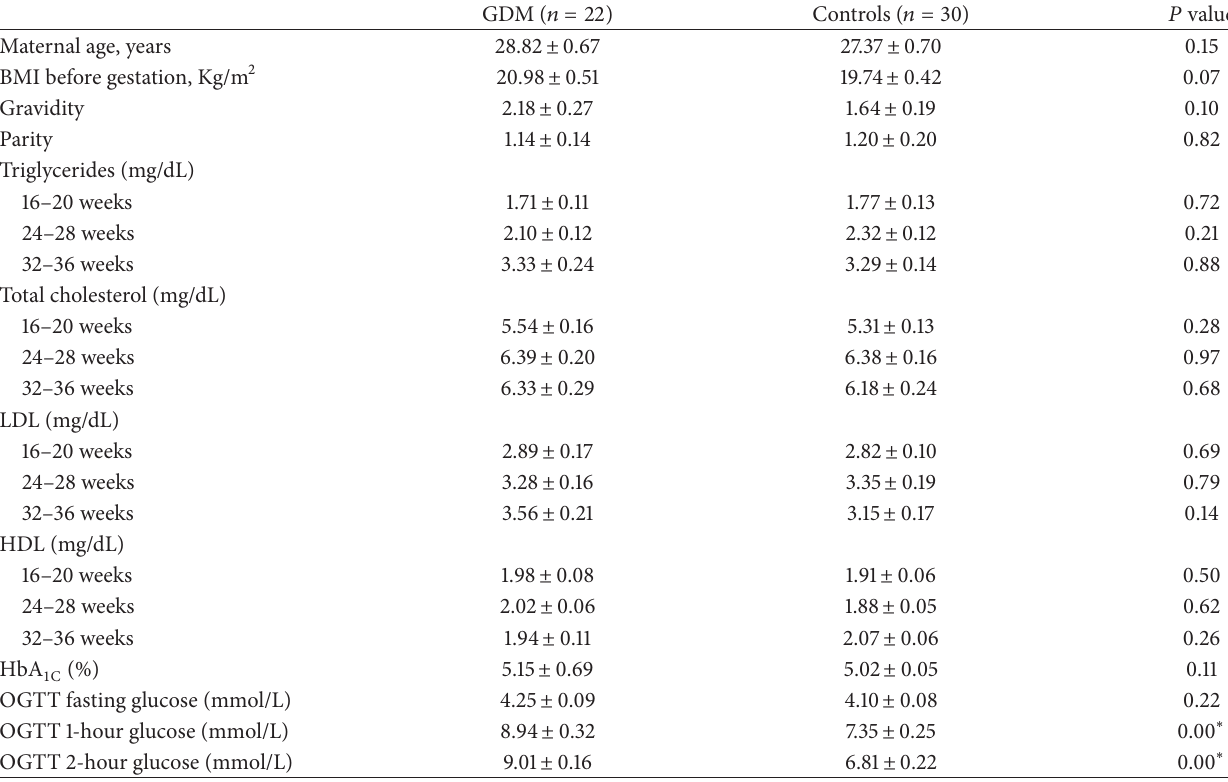
Table 1: Clinical and metabolic characteristics of study subjects.